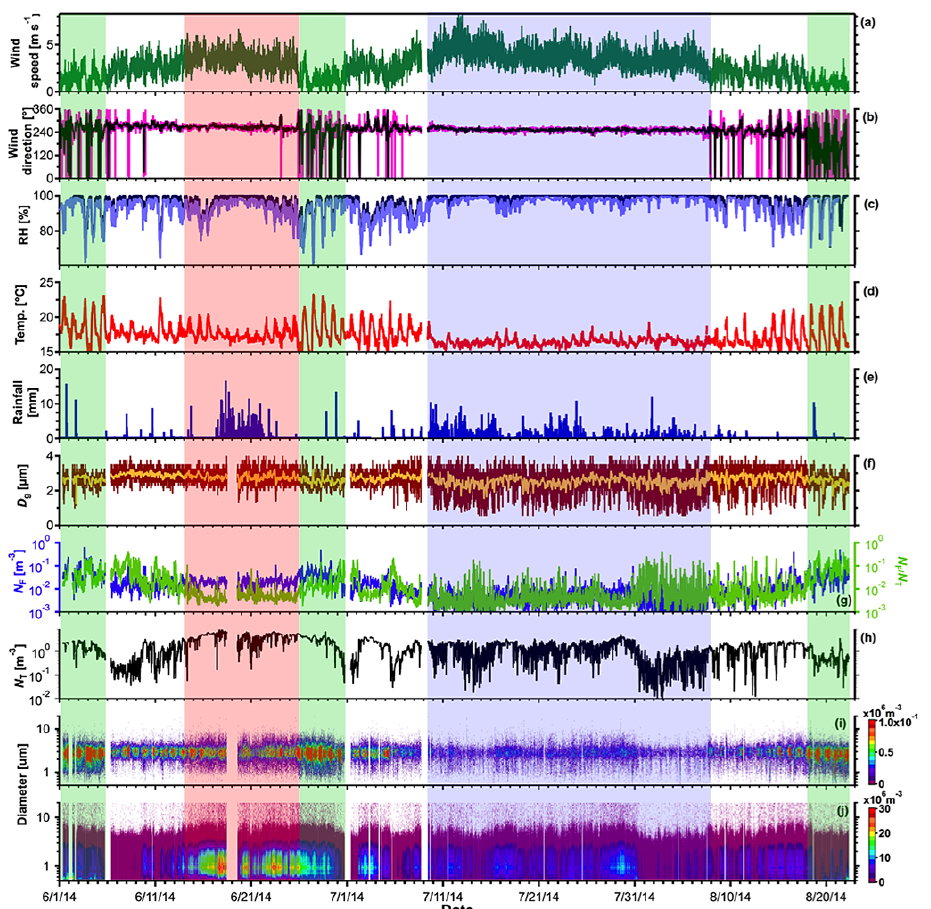
Figure 2. Time series of measured meteorological parameters, parameters derived from FBAPs, and total particle number size distribution measurements using UV-APS: (a) wind speed, (b) wind direction, 5min average (magenta) and 1h average (black), (c) relative humidity, (d) temperature, (e) rainfall, (f) geometric mean diameter ( D g ) , 5min average (dark red) and 1h average (yellow), (g) FBAP number concentration ( N F ; blue) and relative contribution of FBAP to TAP ( N F /N T ; green), (h) TAP number concentration ( N T ) , (i) a contour plot of FBAP number size distribution (d N / dlog D F ) , and (j) a contour plot of TAP number size distribution (d N / dlog D T ) . The shadowed block represents the different focus periods (red for dusty; green for high bio; blue for clean: please refer to the text for more